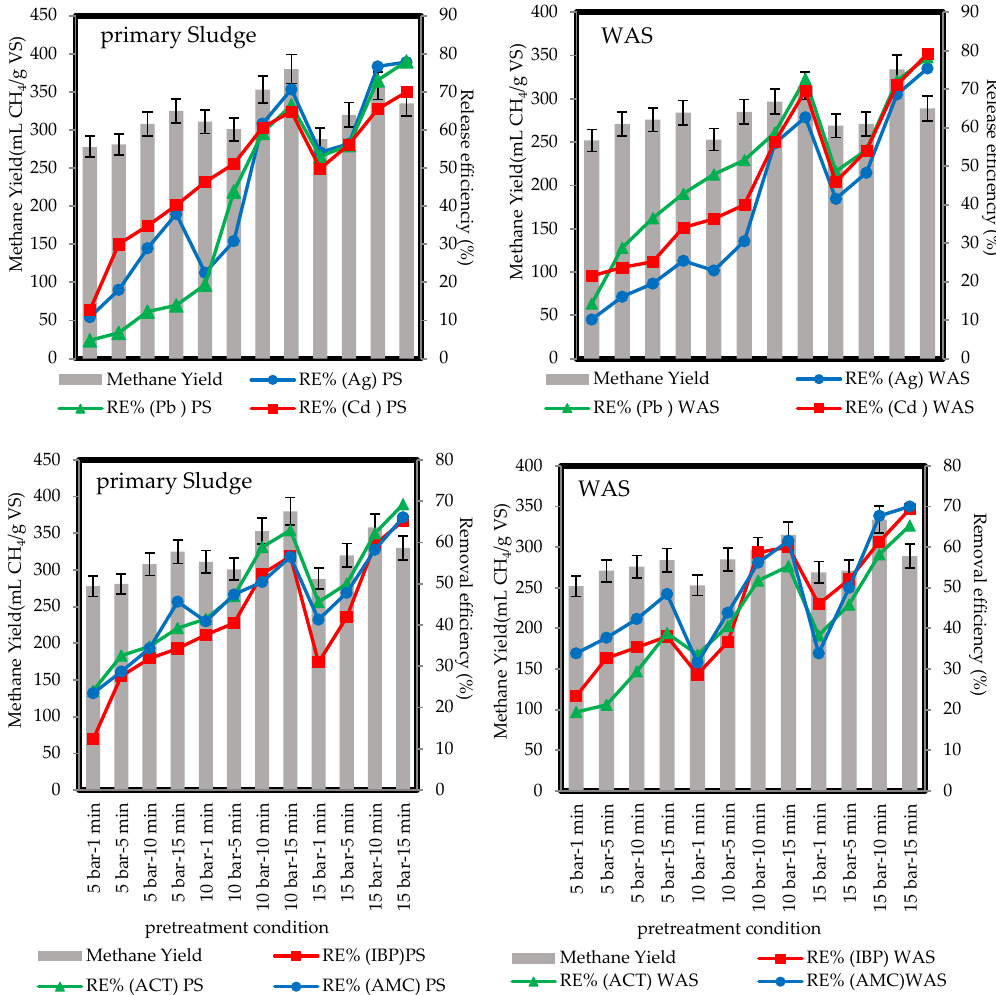
Figure 7. The relation between the removal efficiency of pharmaceuticals and release efficiencies of heavy metals with the methane yield.